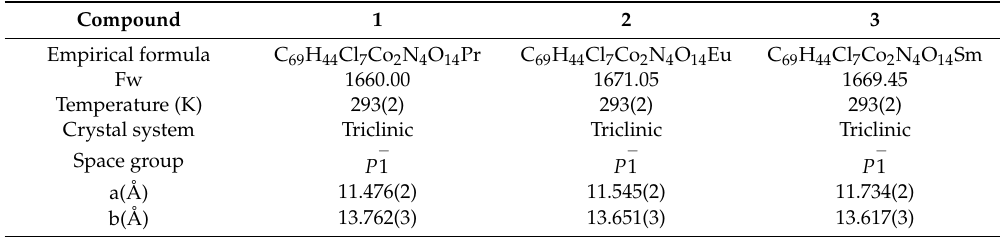
Table 1. Crystal data and structure refinement information for 1 – 3